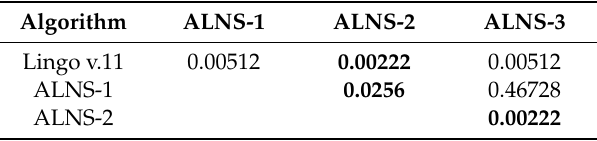
Table 5. p -value of the Wilcoxon sign rank significance